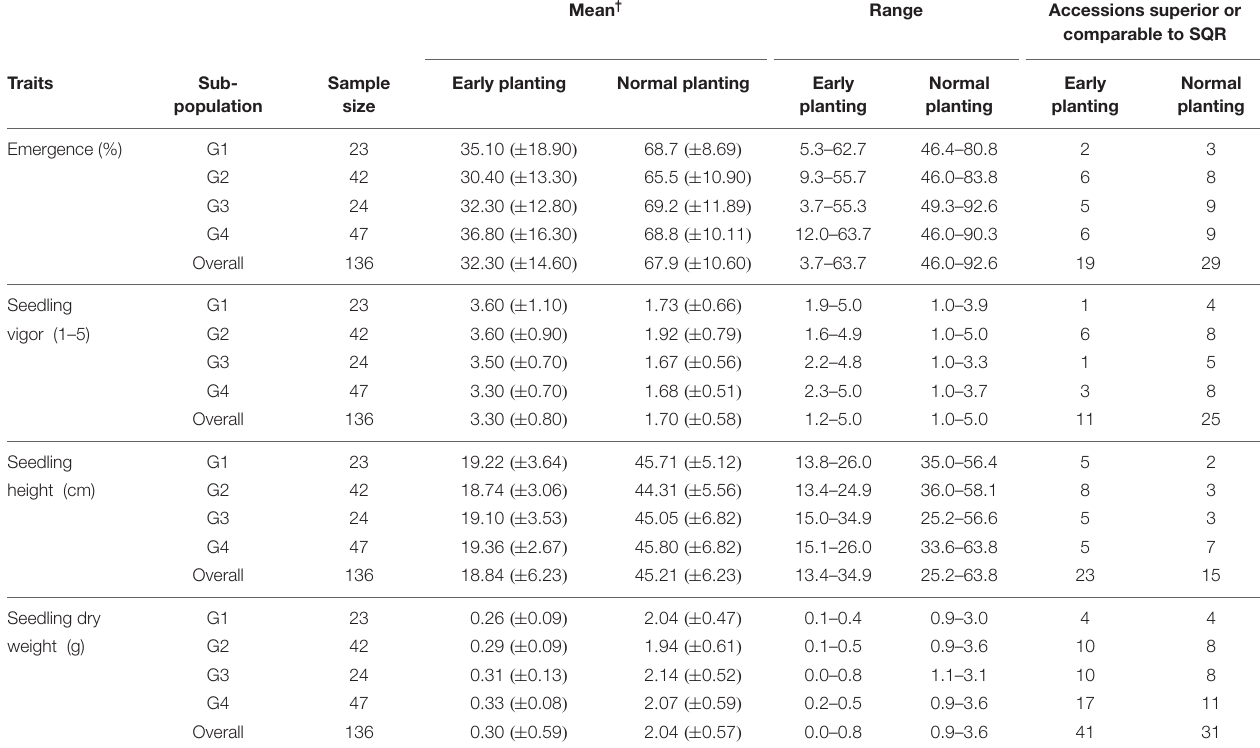
TABLE 5 | Phenotypic responses of the accessions to temperature regimes across subpopulations detected by structure analysis based on 50 SSR markers.